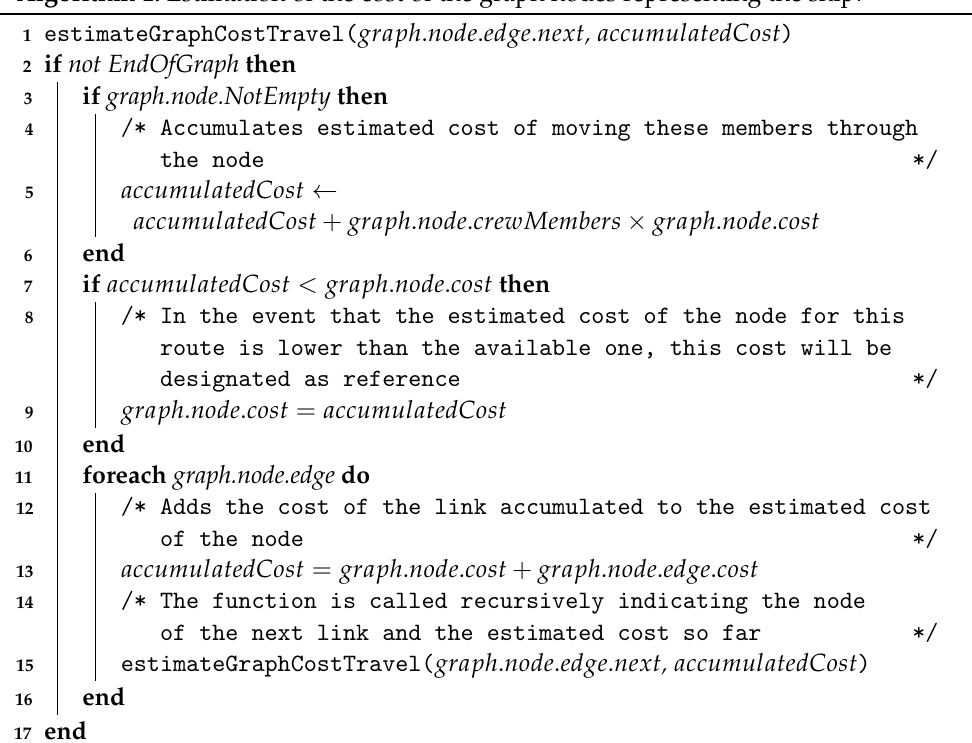
Algorithm 1: Estimation of the cost of the graph nodes representing the